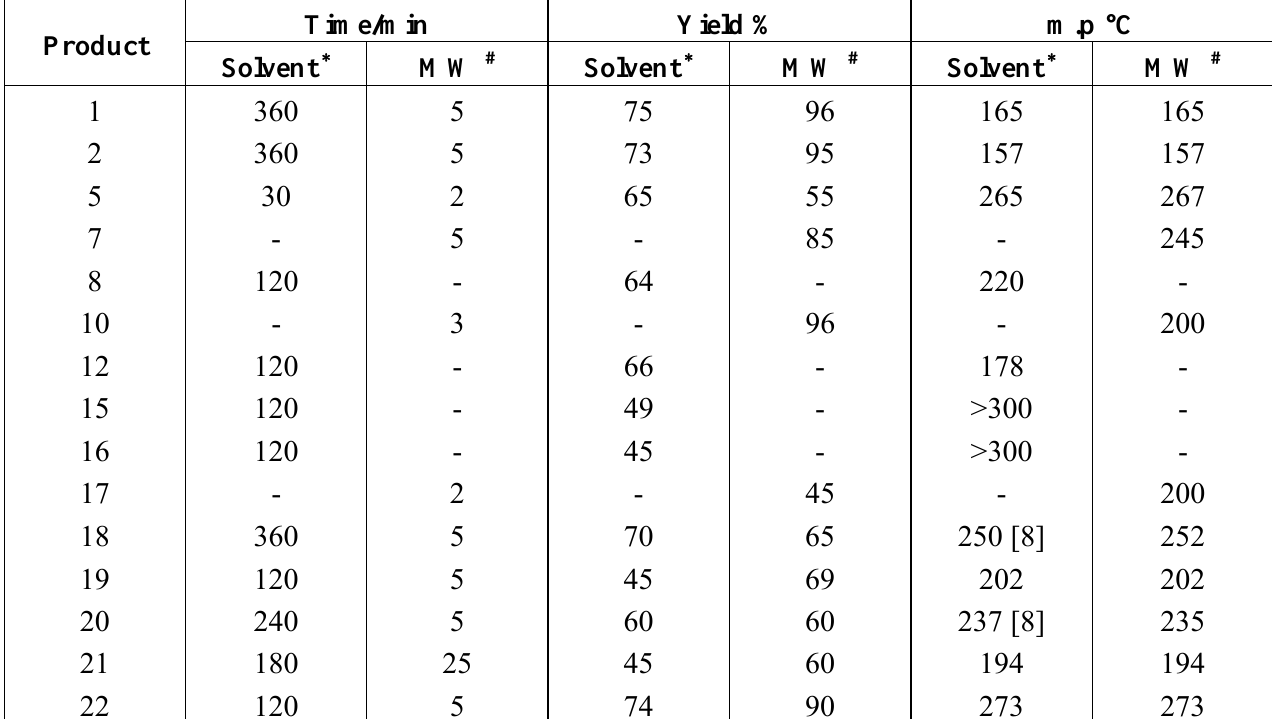
Table 1: Comparison between microwave and solution